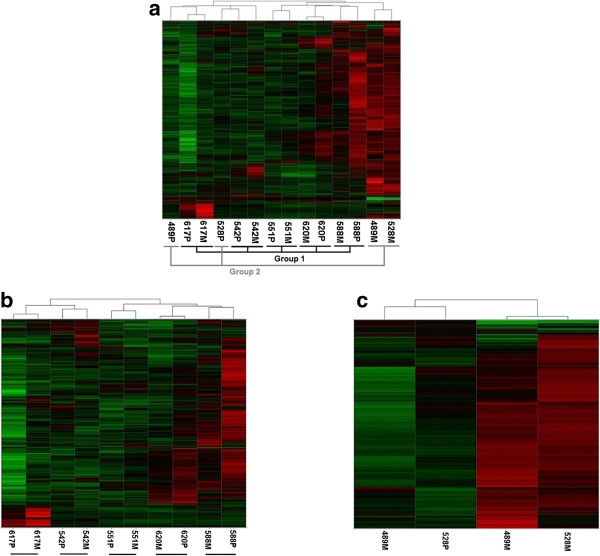
Unsupervised classification of differentially expressed genes between primary and metastatic samples identifies two groups of patients. (a) Unsupervised hierarchical clustering performed on 3,365 unique, annotated genes (4,389 probe sets) displaying significant expression variation across all samples (SD ≥ 0.8). Primary and metastatic samples from 5 patients (617, 542, 551, 620, 588) clustered closely to one another (Group1) while primary and metastatic samples from 2 patients (489, 528) clustered distantly from one another (Group 2); (b) Unsupervised hierarchical clustering of the same genes/probe sets in (a) across primary (P) and metastatic (M) samples of Group 1 patients. All P samples cluster most closely with their matched M samples for all patients; (c) Unsupervised hierarchical clustering of the same genes/probe sets in (a) across primary (P) and metastatic (M) samples of Group 2 patients. The P samples do not cluster with the matched M samples of the same patient.